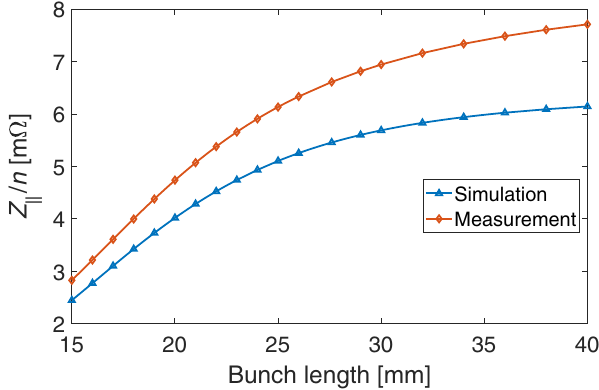
FIG. 14. The longitudinal effective impedance as a function of rms bunch length obtained from coaxial wire measurement and wakefield